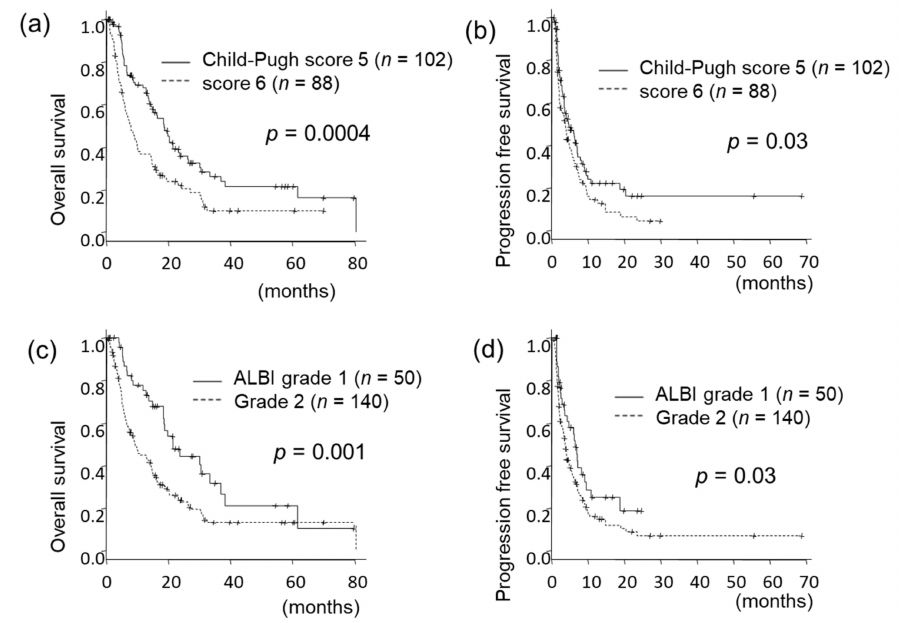
Figure 1. Overall survival (OS) and progression-free survival (PFS) stratified by Child–Pugh score or ALBI grade. Patients within Child–Pugh score 5 at baseline had significantly prolonged OS ( a ) and PFS ( b ) compared with those with score 6. Patients with ALBI grade 1 had significantly prolonged OS ( c ) and PFS ( d ) compared with those with grade 2.